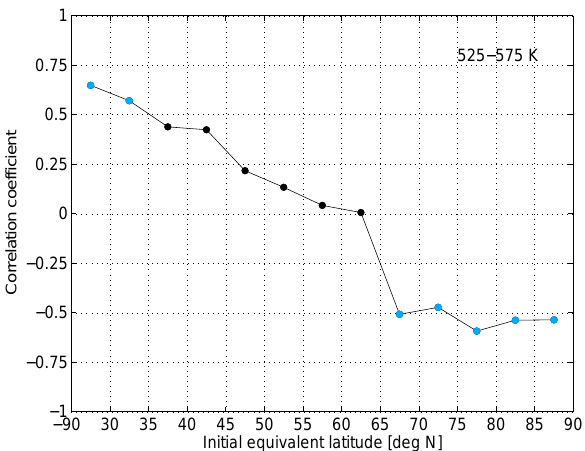
Fig. 14. Correlation of the origin of air inside the polar vortex and EP flux through mid latitudes in autumn. Each colored box shows the correlation coefficient of a time series of EP flux through a layer in autumn and a time series of an origin tracer in early winter at the same layer (1992–2009). The EP flux time series is the vertical component of the flux through the layer given at the vertical axis av- eraged over 45–75 ◦ N and from September to November. The ori- gin tracer is the fraction of vortex air in early winter originating from the equivalent latitude intervals given at the horizontal axis on 1 September and averaged over the potential temperature intervals given at the vertical axis. Correlation coefficients not significant at the 95% level are crossed out. Time series are